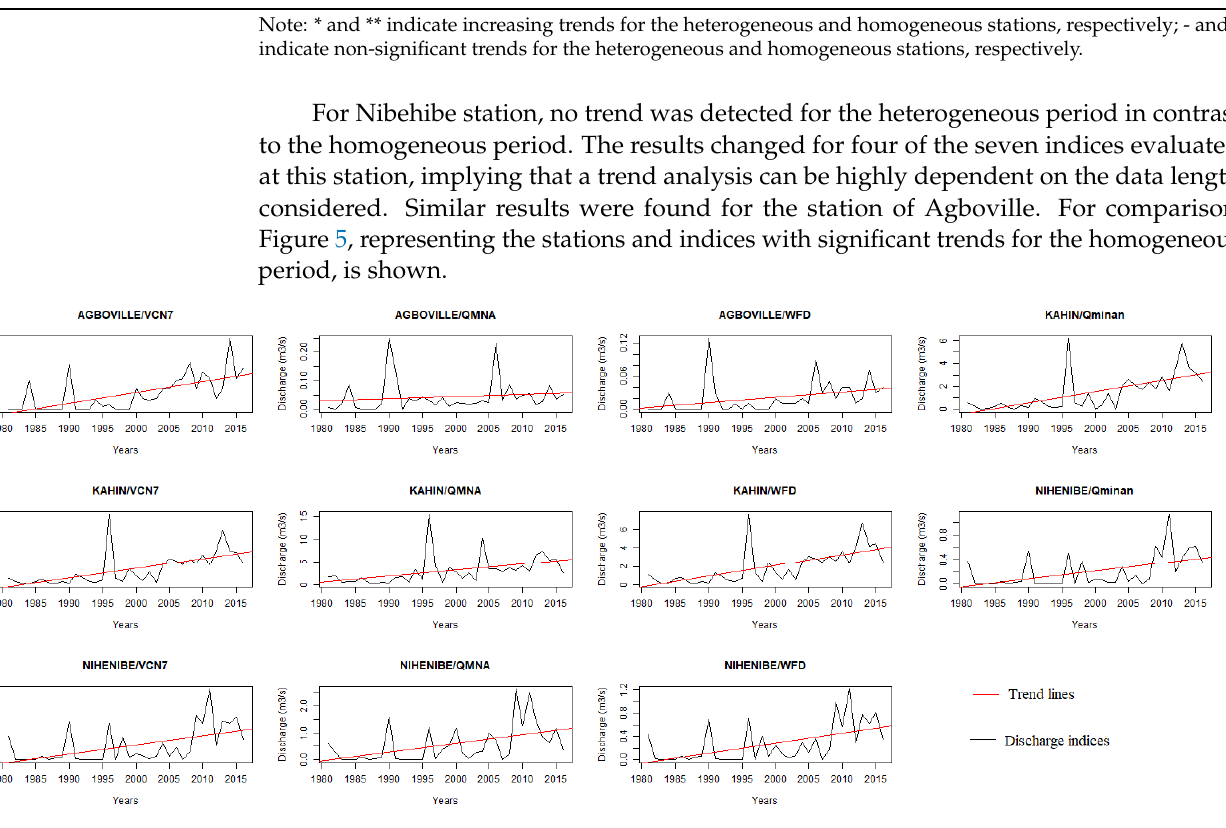
Figure 5. Significant trend results for the homogeneous stations .